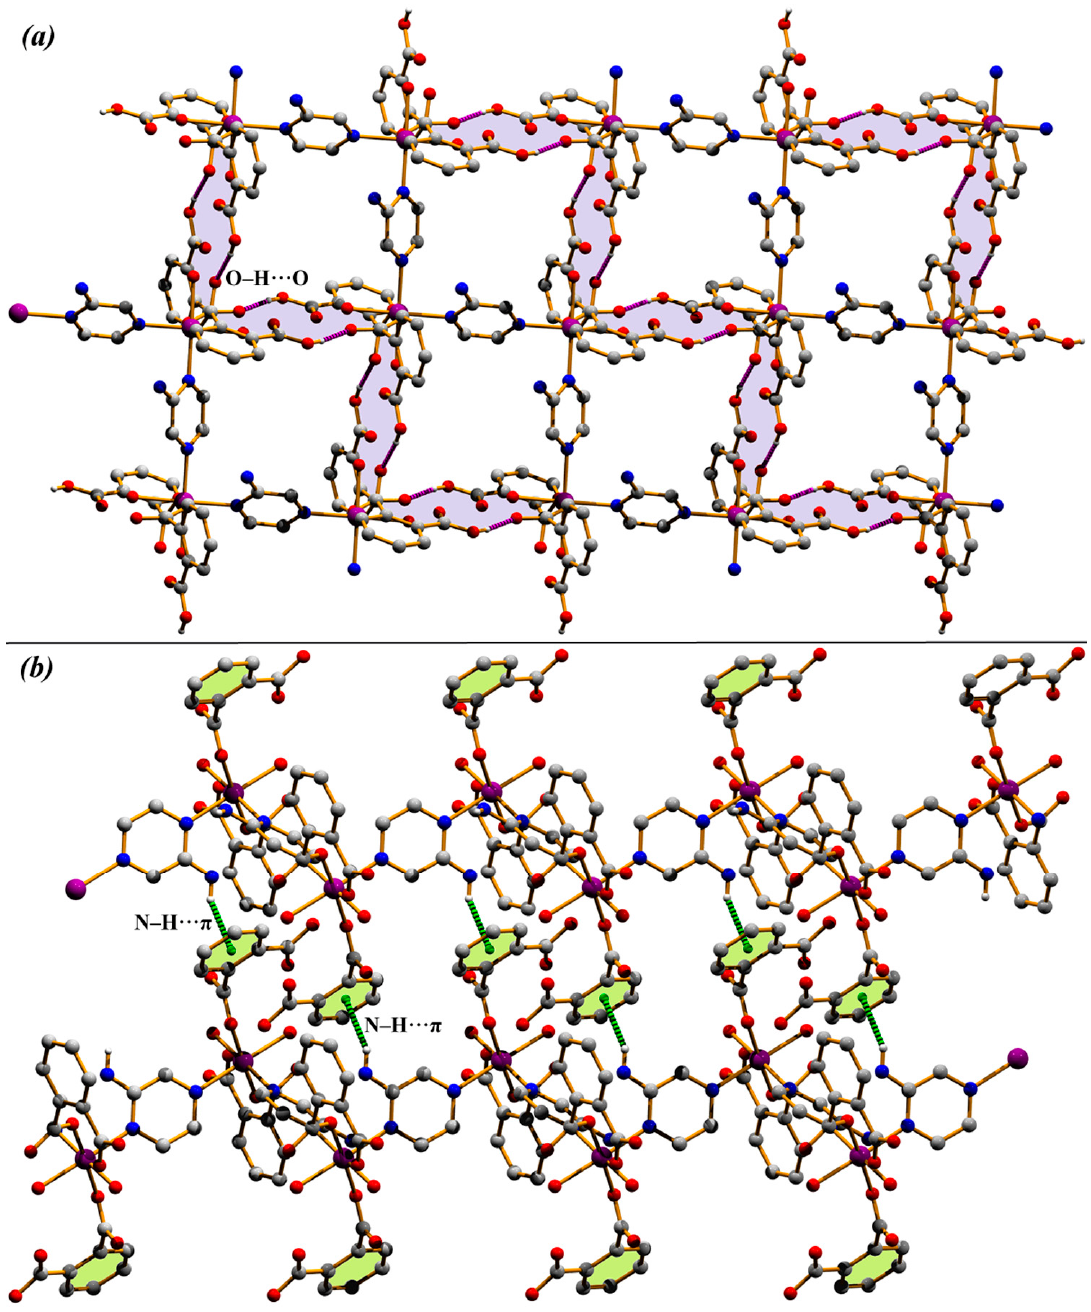
Figure 3. ( a ) Two-dimensional network in (011) plane through O-H ··· O hydrogen bonding interaction. ( b ) Layered framework in (011) plane through N-H ··· π interaction in 1 . One amino group of the aminopyrazine moiety with partial occupancy factor has been used to draw the figures.